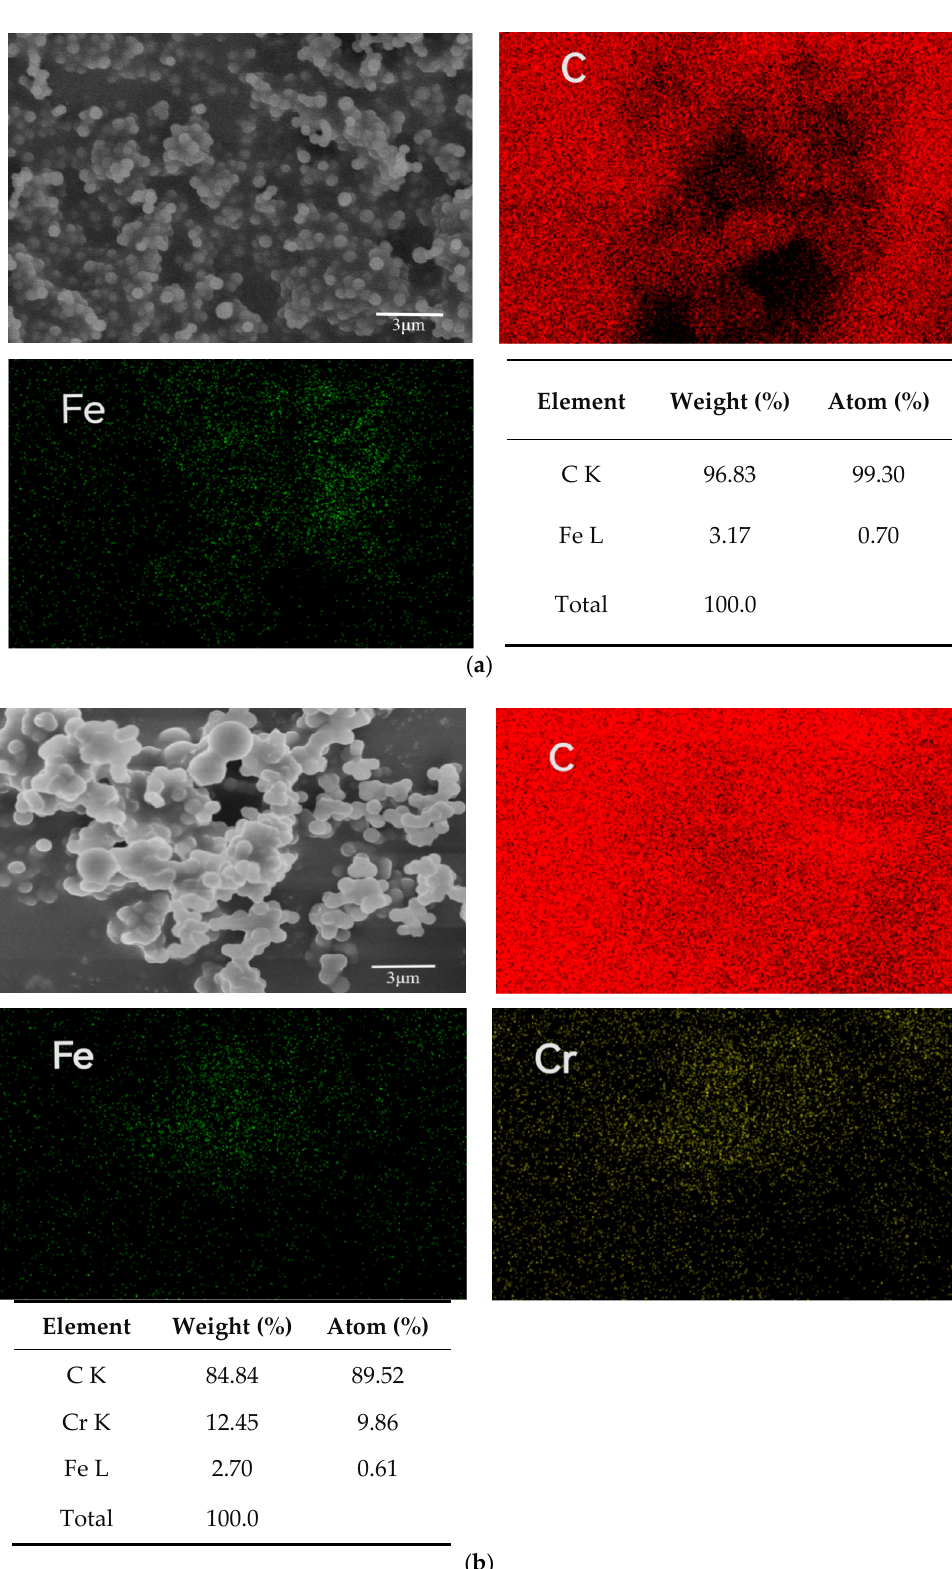
Figure 4. Structure and morphography of RC-nZVI detected with FE-SEM and EDS: ( a )